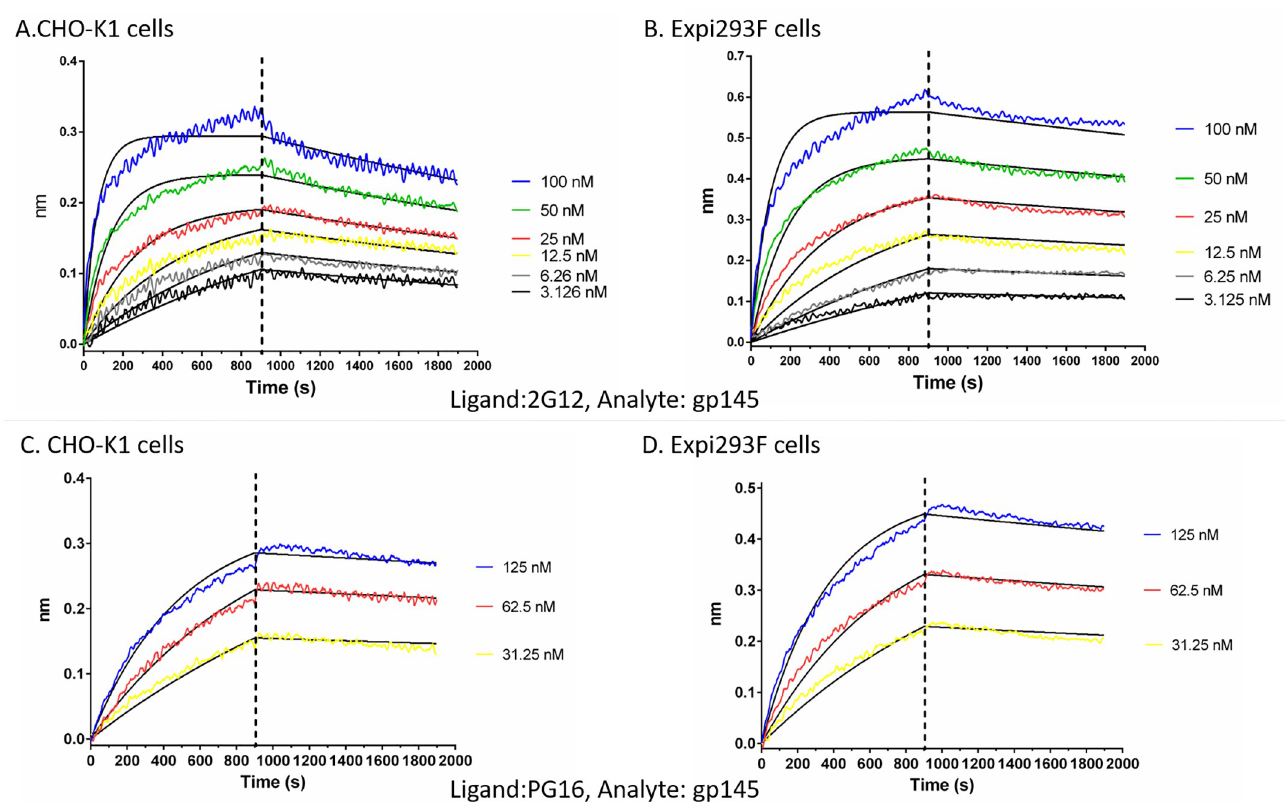
Fig 6. Binding of 2G12 and PG16 bNAbs to HIV-1 gp145. ( A-D ) Octet QK e sensorgrams generated by binding of serial of dilutions of gp145 produced in CHO-K1 and Expi293F cells to 2G12 and PG16 bNAbs loaded onto anti-human IgG FC capture (AHC) biosensors. Tables show the k a (rate of association), k d (rate of dissociation) and K D (dissociation constant) values for the interactions of HIV-1 gp145 to ( A-B ) 2G12 and ( C-D ) PG16 bNAbs. Black lines represent the 1:1 global fit curve.